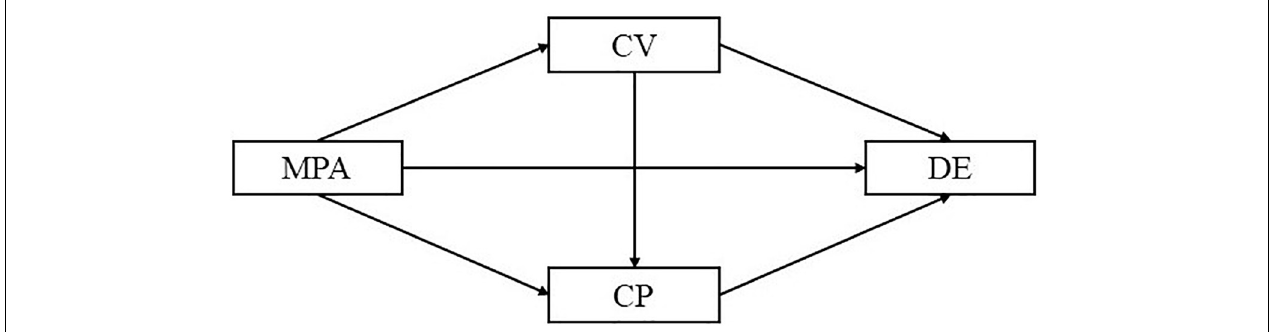
FIGURE 1 | A hypothetical sequential mediating model diagram. MPA, mobile phone addiction; CV, cyberbullying victimization; CP, cyberbullying perpetration; DE,